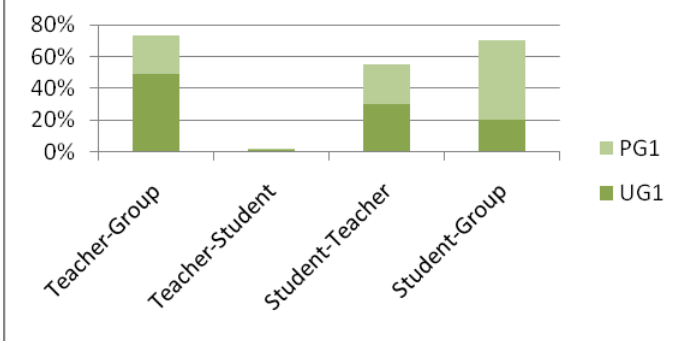
Figure 6: Categories of Exchanges in the Online Discussion Forums in